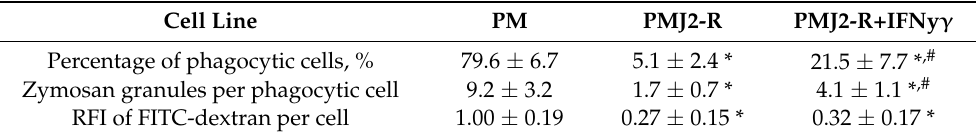
Table 2. Phagocytic activity of PMJ2-R and PM